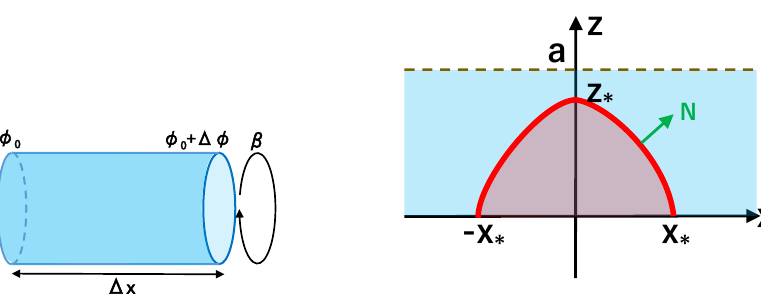
Figure 20 . The cylinder geometry where the dual BCFT 2 is defined (left) and the profile of connected EOW brane in thermal AdS 3 /BTZ black hole